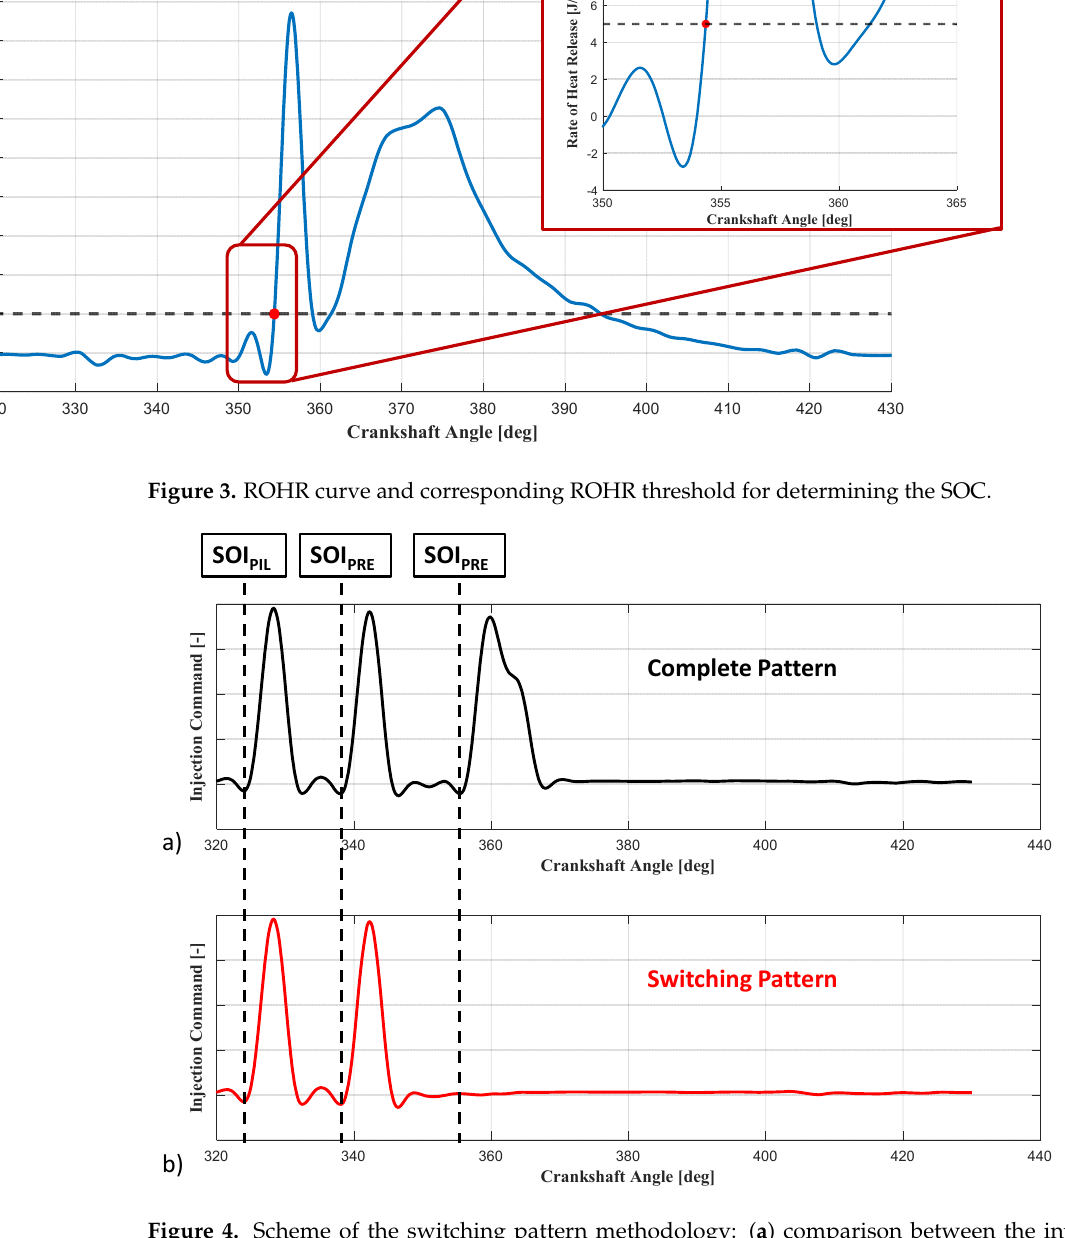
Figure 4. Scheme of the switching pattern methodology: ( a ) comparison between the injection commands of both complete (cycle n − 1 and n + 1) and ( b ) switched pattern (cycle n).